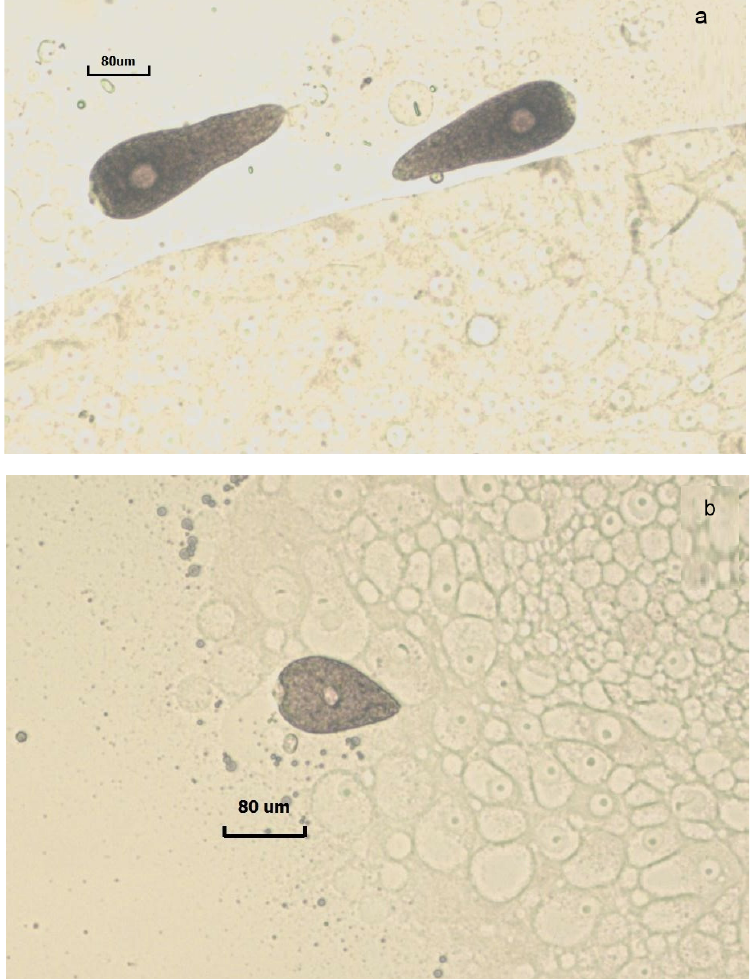
Figure 2. Trophozoites in the mid-gut of the larvae, (a) Ascogregarina culicis in Aedes aegypti (b) Ascogregarina sp. in Aedes albopictus (bar=80